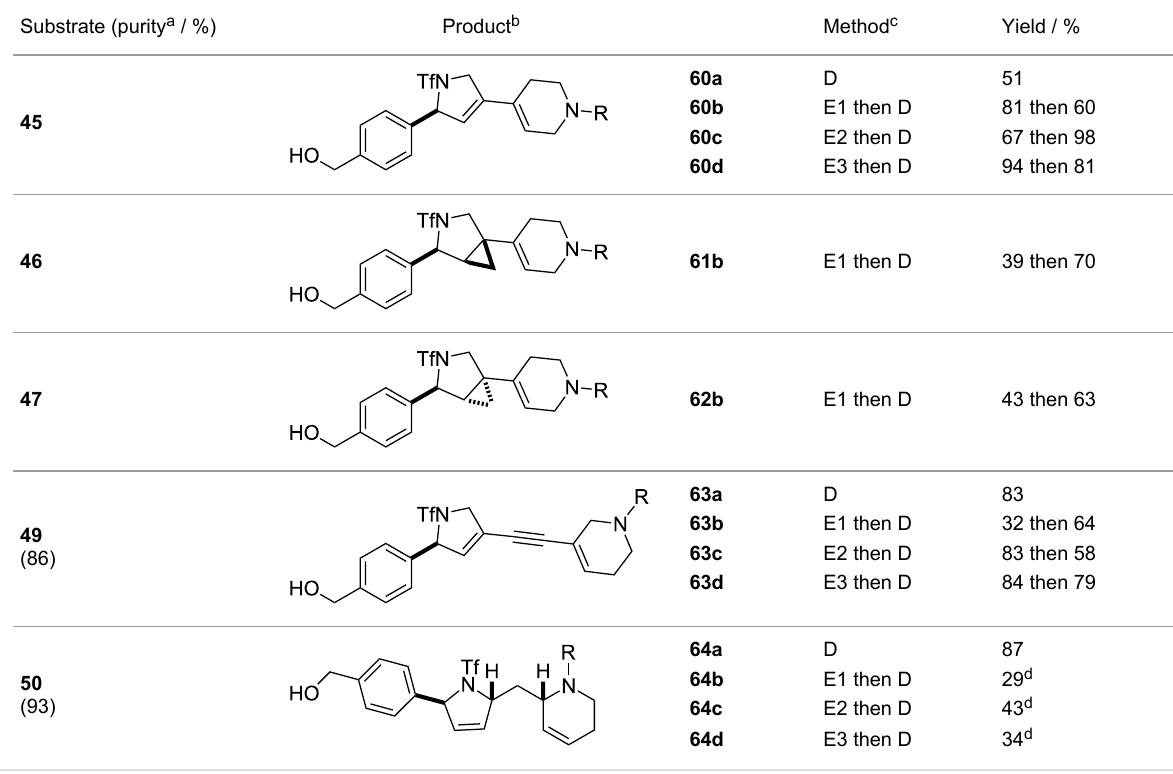
Table 4: Derivatisation and deprotection of final products. Substrate (purity a /